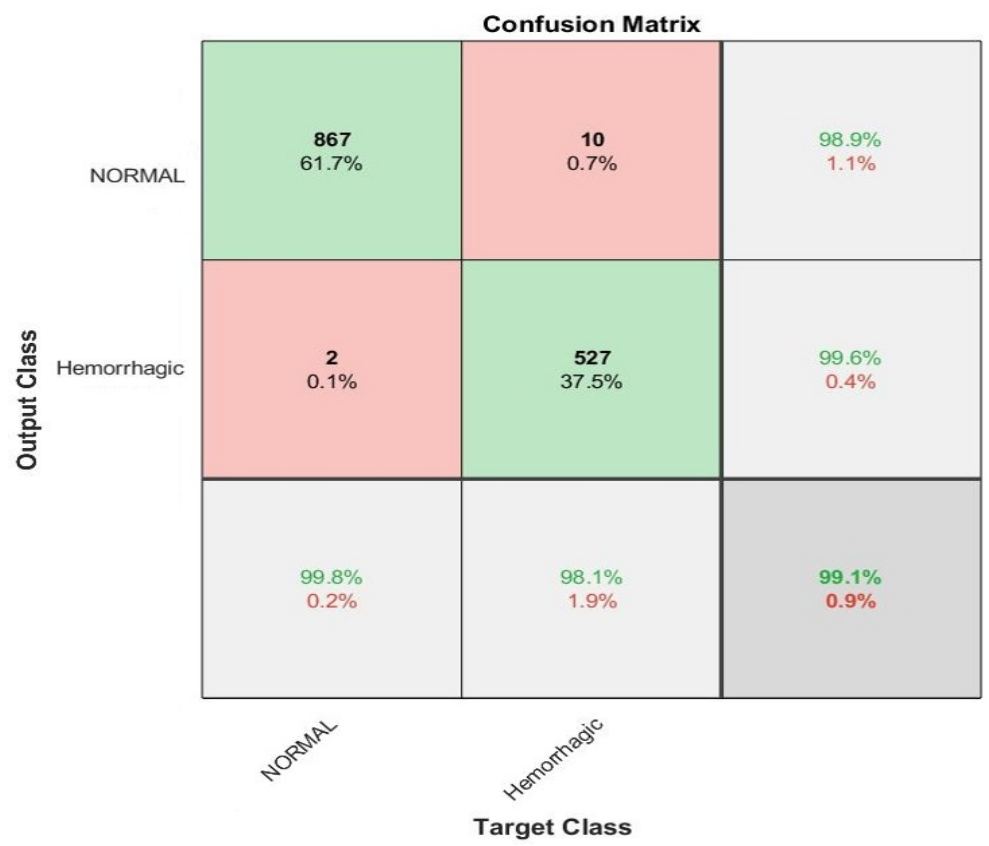
Figure 20. ANN’s confusion matrix based on features fused between ResNet-50 and GLCM and